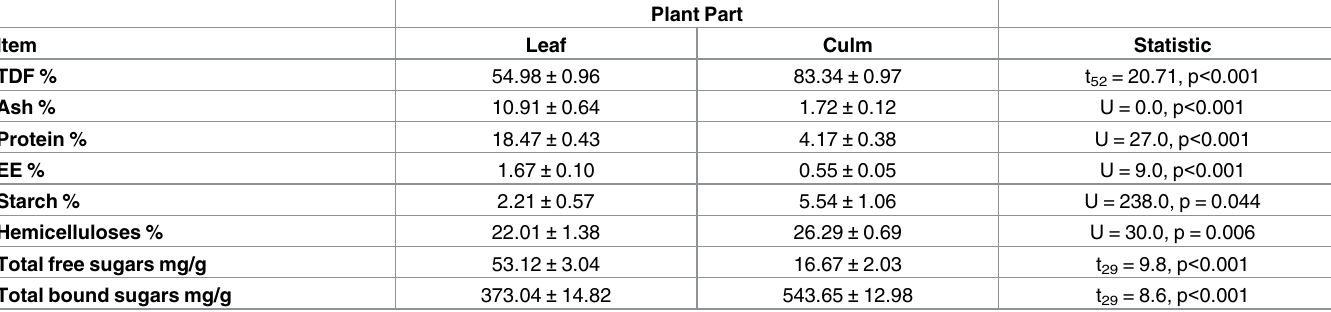
Table 3. Nutrient components (Mean ± SEM) in leaf and culm during spring (March-May) in four Phyllostachys bamboos.